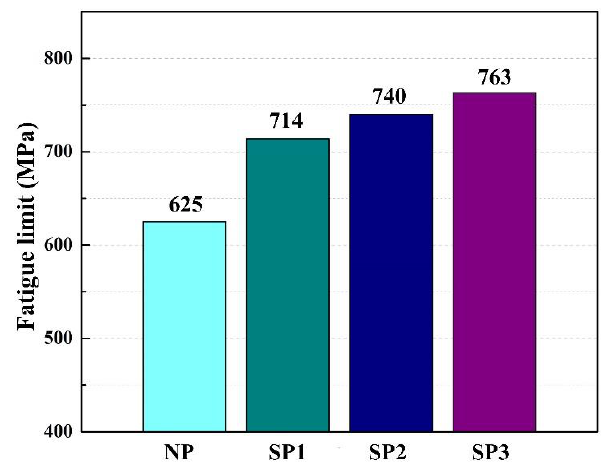
Figure 8. Local fatigue limit of the notched specimens (2 million).